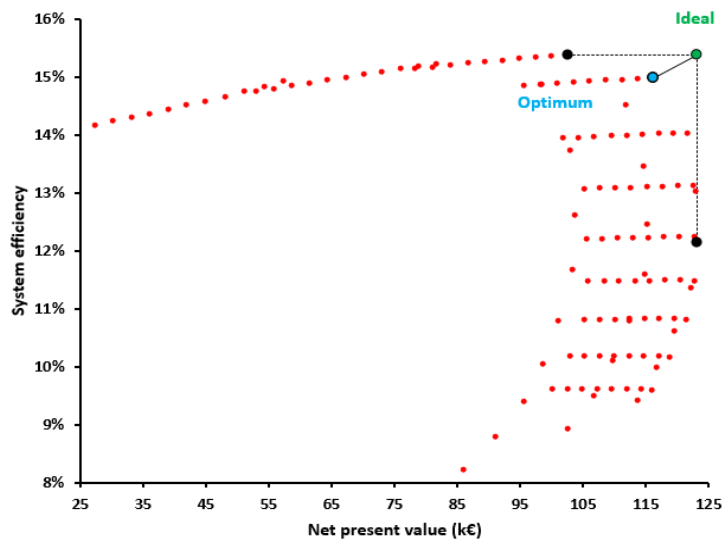
Figure 8. Pareto-front and multi-objective optimization depiction with the system efficiency and the net present value as the optimization goals. (The black points are the side points, the green point is the ideal point and the blue point is the optimum point).